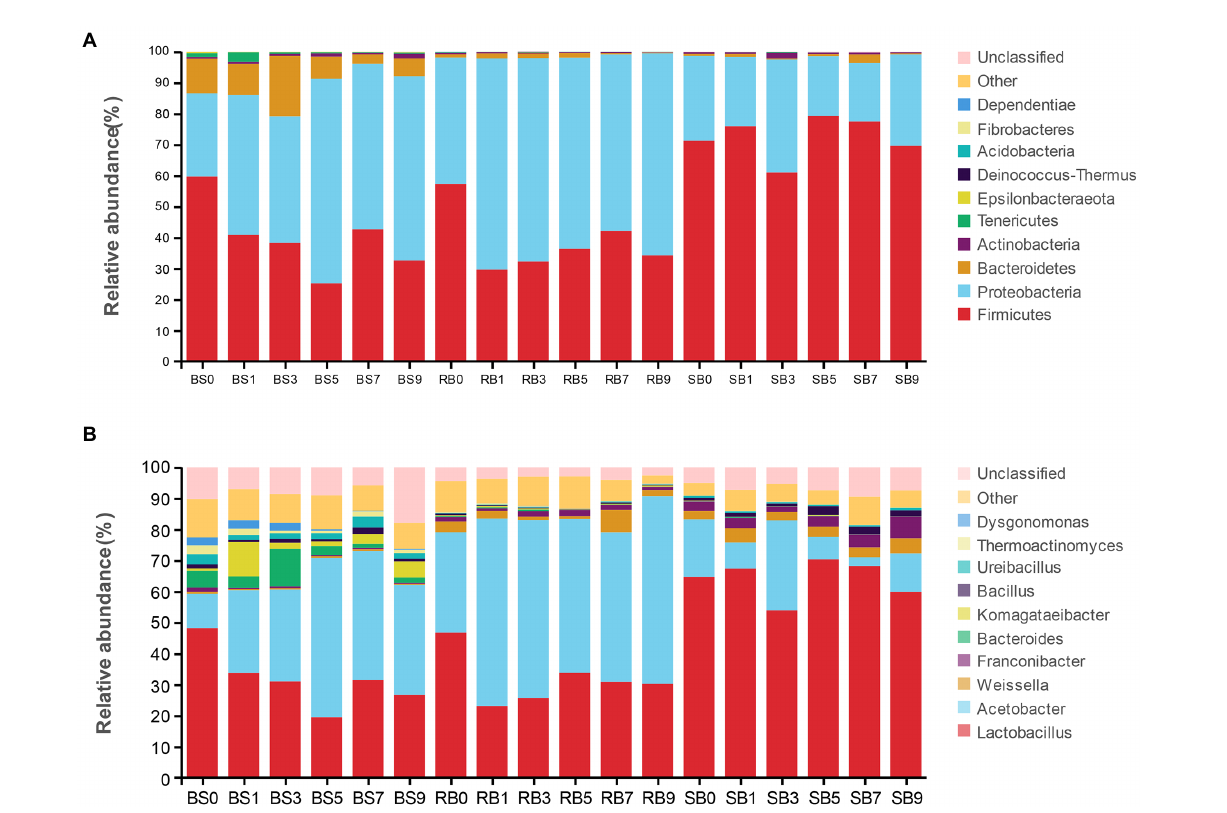
FIGURE 3 The dynamic bacterial community of the WPCS during aerobic exposure. The bacterial communities were shown at the phylum level (A) and the genus level (B) . BS, Bunker silo; RB, Round bale; SB, silage bag. 0, 1, 3, 5, 7, 9: 0, 1, 3, 5, 7, 9 days of aerobic exposure,